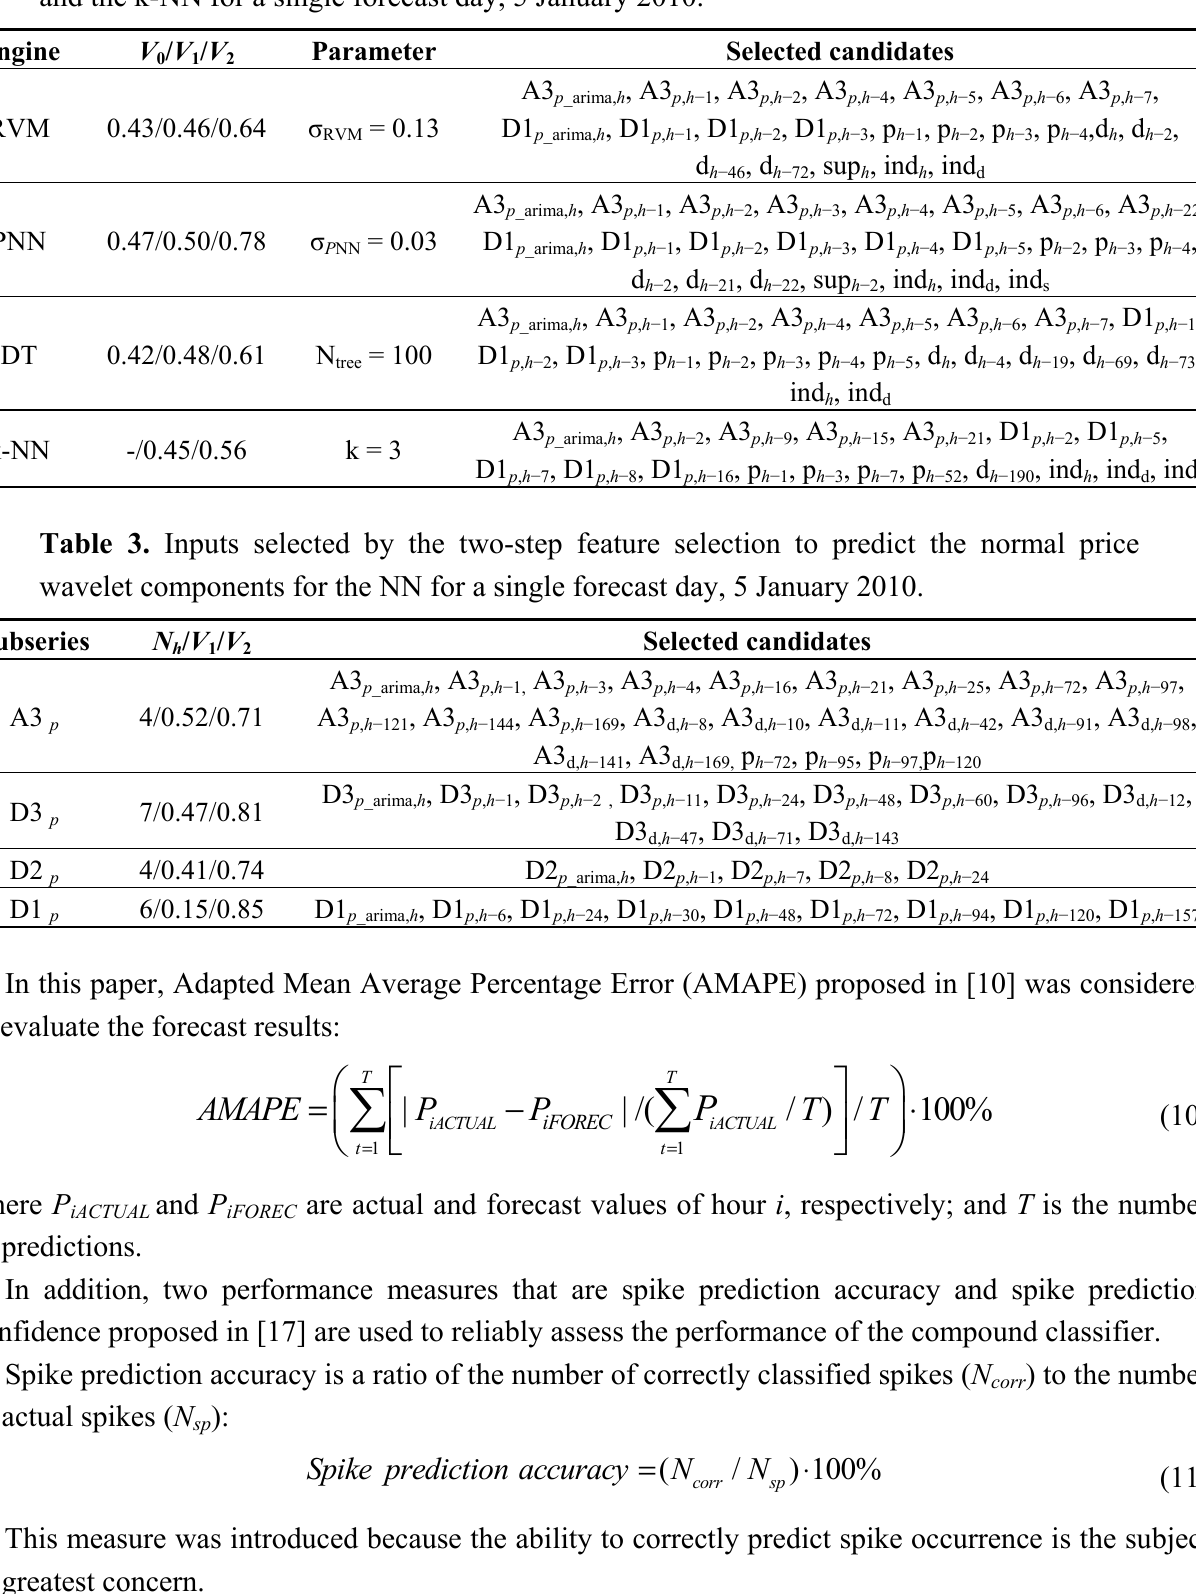
Table 2. Selected inputs for the three classification approaches of the compound classifier and the k-NN for a single forecast day, 5 January 2010.